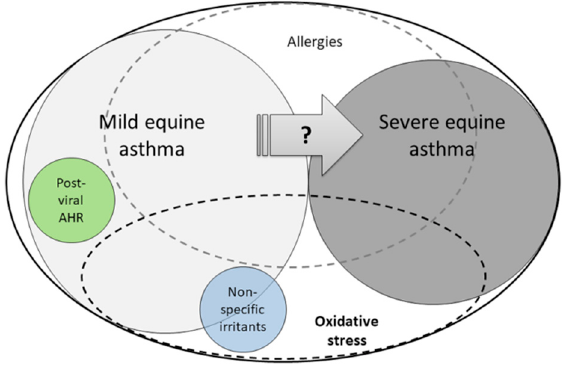
Figure 3. Equine asthma phenotypes. Oxidative stress plays a role in both mild and severe forms of equine asthma. equine